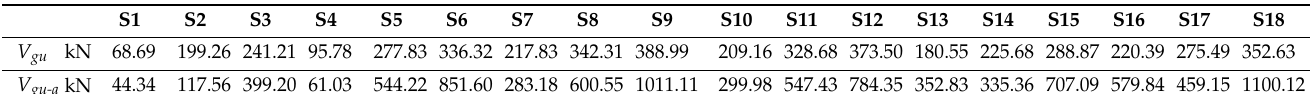
Table 3. Comparisons between results from this analytical model and results from code provisions. First row: number of the case Study (S1–S18), which are those of Table 1. Second row: V gu from the analytical model, i.e., shear strengths of the anchor groups reported in Table 1. Third row: shear strength from Appendix B of the Aci code [80], which is denoted by Vgu-a . Each column compares thus the analytical result to the Aci code provision for each case study of Table